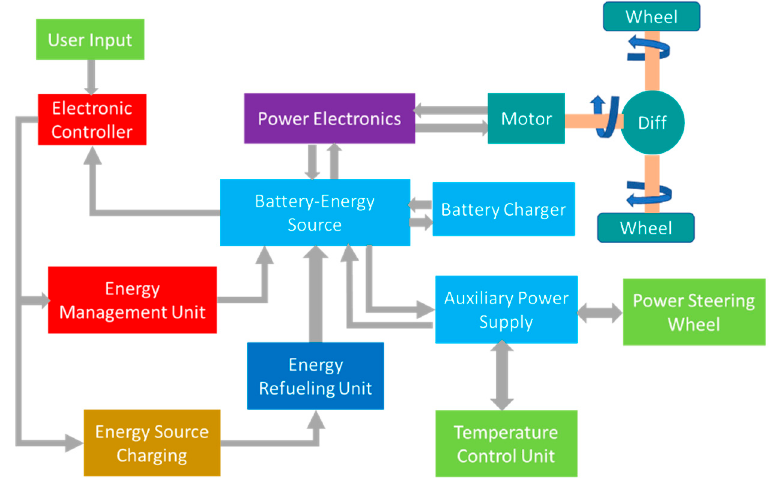
Figure 2. Vehicle powertrain architecture.